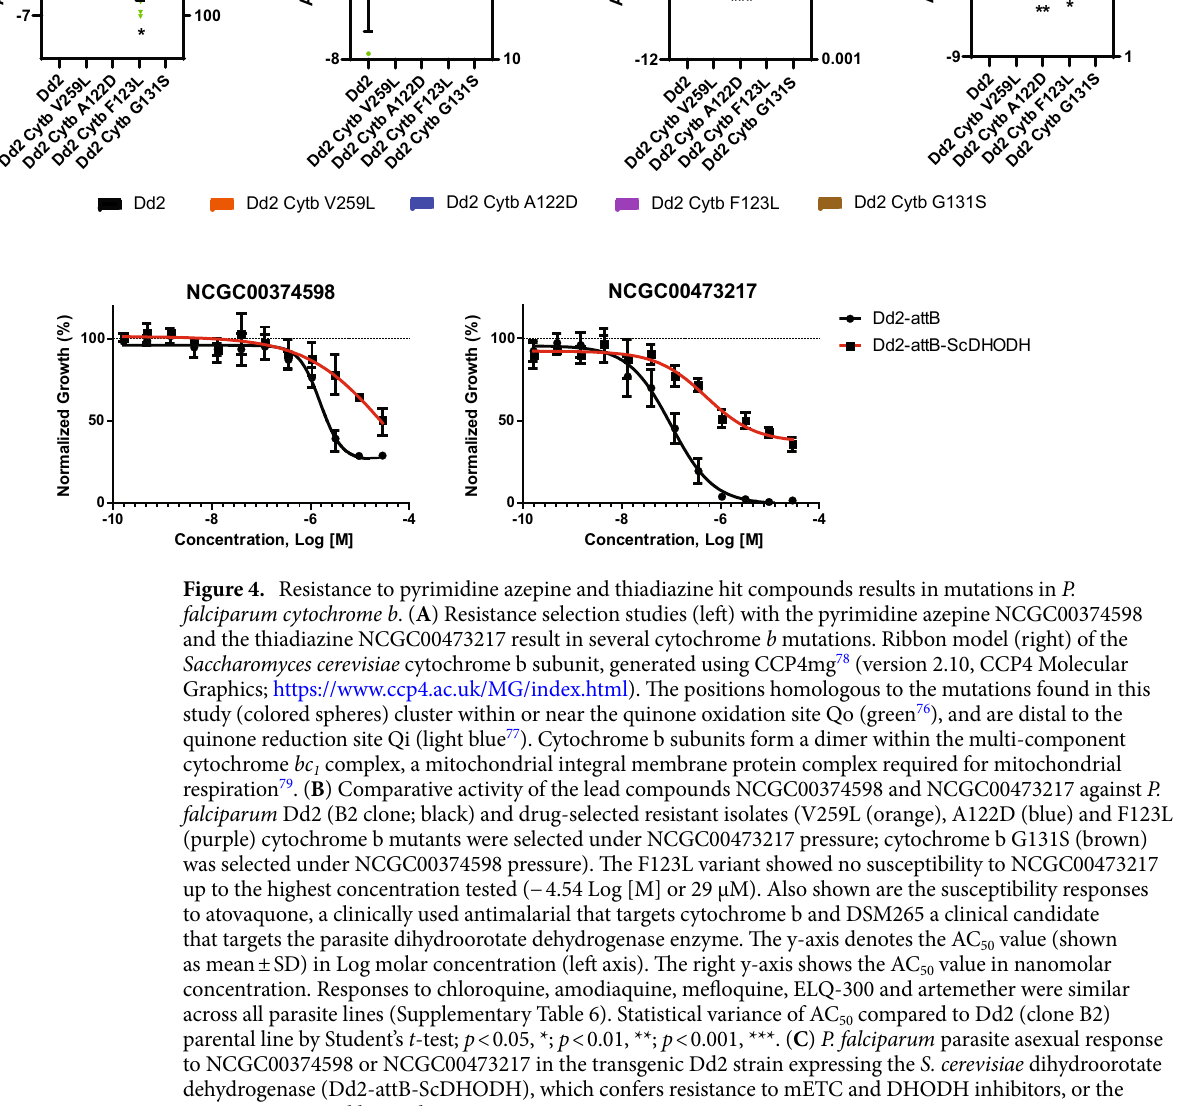
transgenic parental line